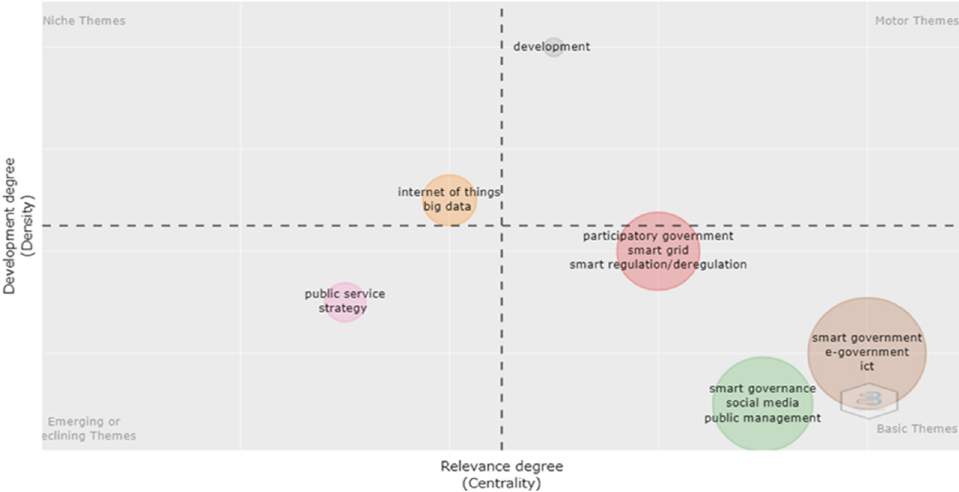
Figure A2. Thematic map of SPG smart government research. Table A1. Research subfields based on authors’ keyword co-occurrence network in SPG smart city research.